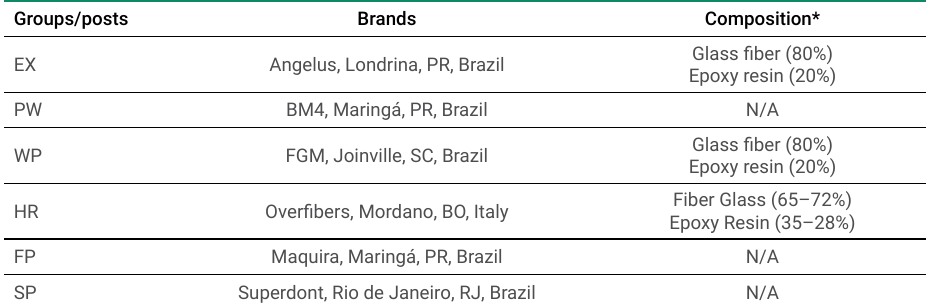
Table 1. Experimental groups